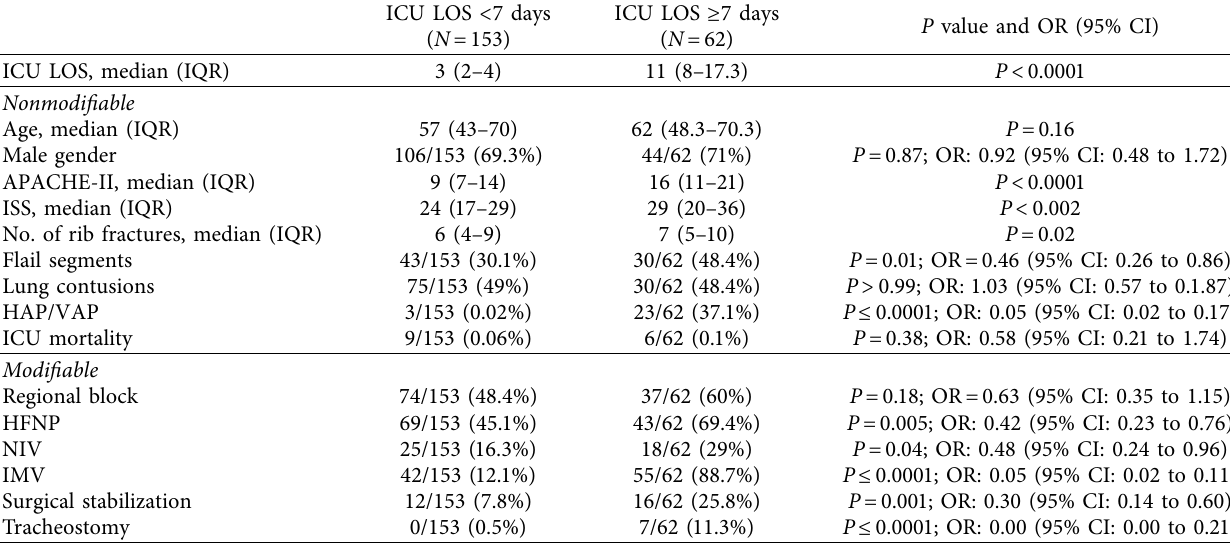
Table 2: Comparison between patients with ICU LOS of less than 7 days and patients with ICU LOS of 7 or more